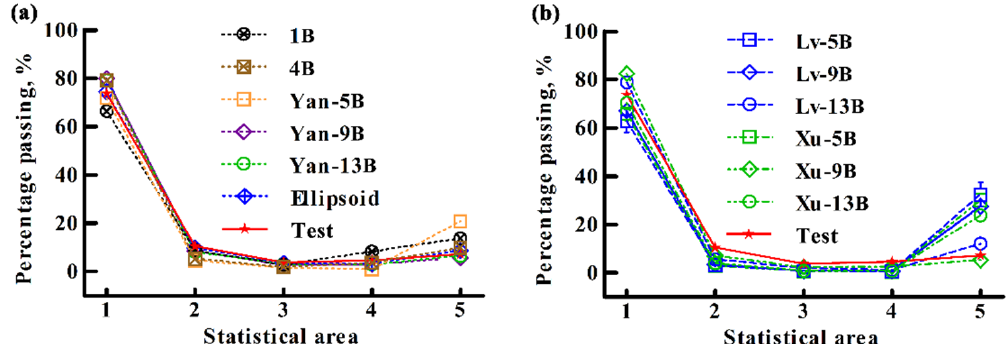
Figure 17. Comparisons of the simulated percentages passing with the test ones in different statistical areas in the “self-flow screening” of Z-39 soybean particles for ( a ) the 1B, 4B, Yan-5B, Yan-9B, Yan-13B, and Ellipsoid models, as well as ( b ) the Lv-5B, Lv-9B, Lv-13B, Xu-5B, Xu-9B, and Xu-13B models.